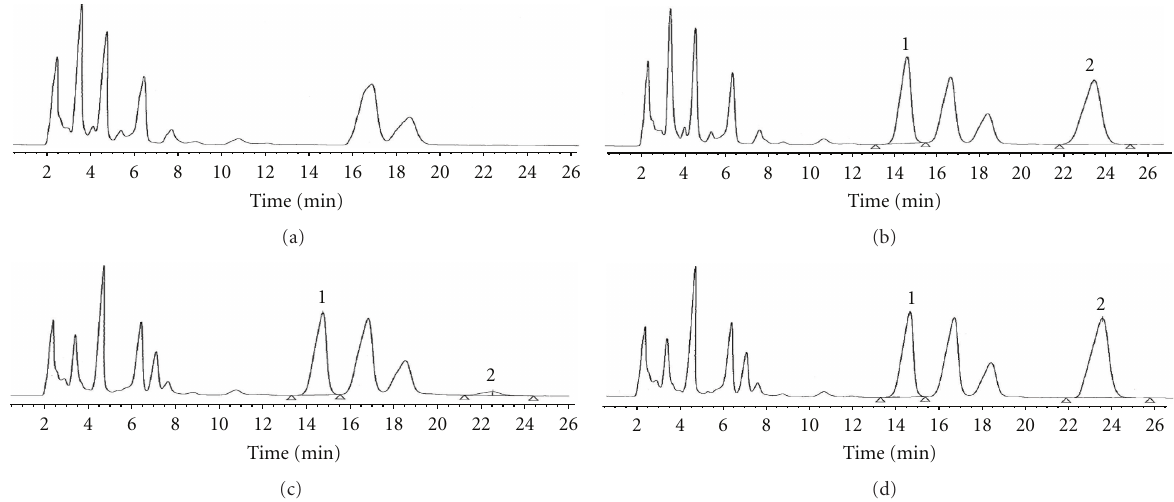
Figure 2: Chromatograms of (a) a liver sample from a rat treated only with physiological saline; (b) a rat liver extract spiked with APAP-Cys (2.5 µ g/100 µ L) and PABA, the internal standard; (c) a liver extract from a rat treated with APAP (800mg/kg i.p.); (d) a liver extract from a rat treated with APAP (800 mg/kg i.p.) and spiked ex vivo with authentic APAP-Cys (2.5 µ g/100 µ L of liver extract). Key: 1, PABA, the internal standard; 2, APAP-Cys adduct.